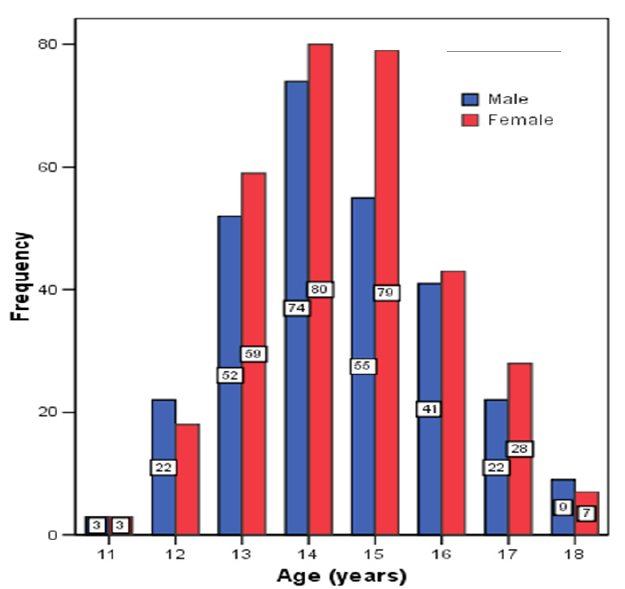
Figure 1: Distribution of children by age and gender Of the 595 children examined, only 79 (13.3%)